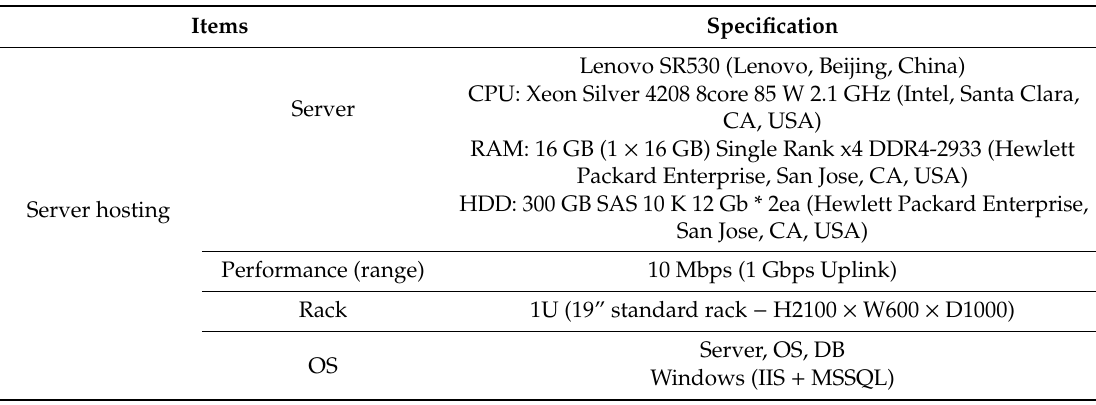
Table 6. Specifications of the platform